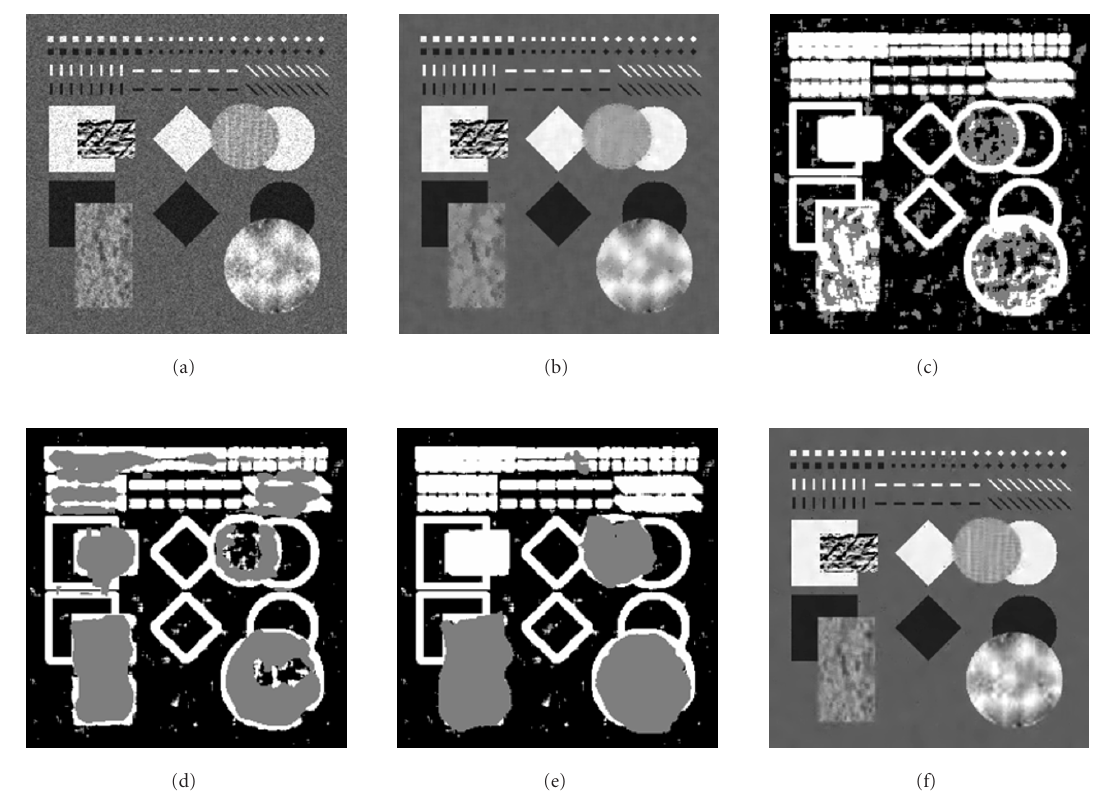
Figure 7: Examples of the test image (Figure 1) processing: (a) the test image corrupted by multiplicative Gaussian noise with σ 2 µ = 0 . 012, (b) the output of the two-state hard-switching LAF, (c) the result of two-threshold preclassification (7), (d) the “CPC1” classification map, (e) the “CPC2” classification map, and (f) the output of the three-state hard-switching LAF processing according to the CPC2 map.